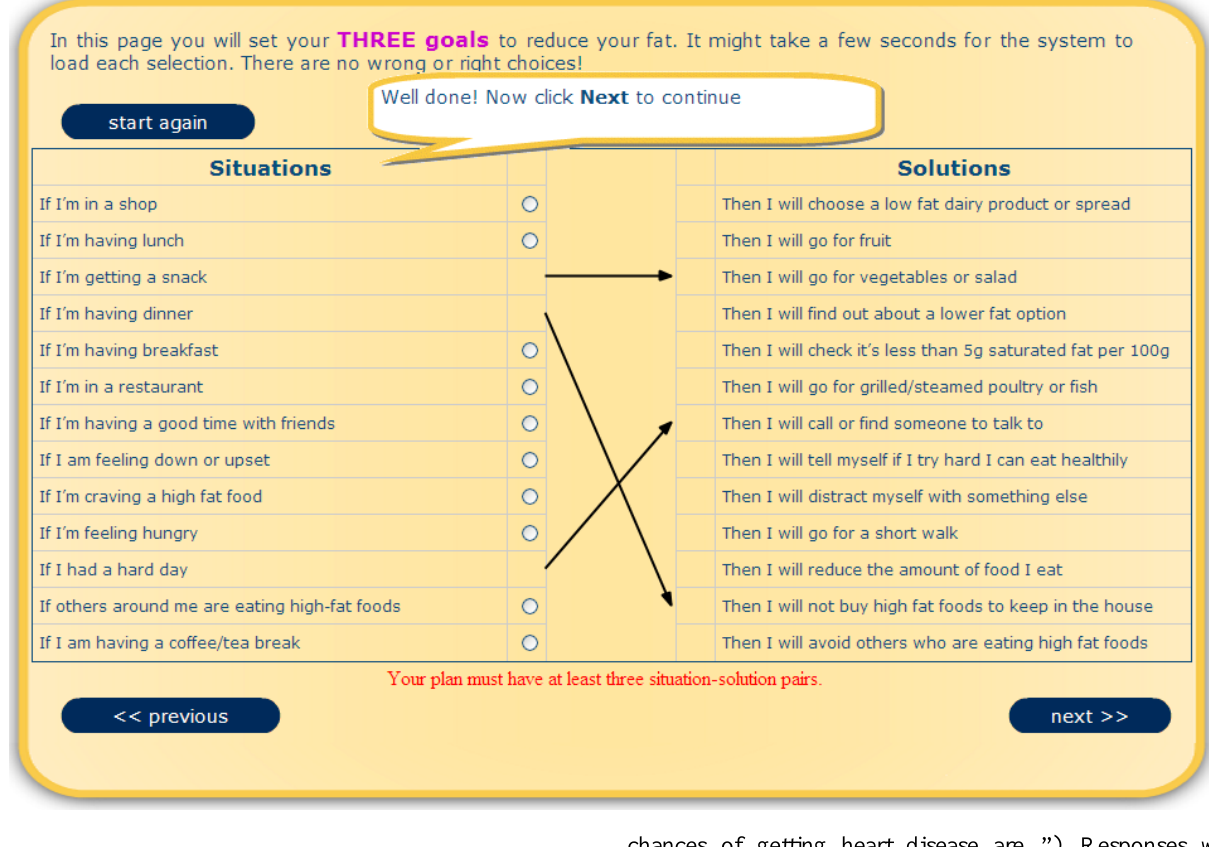
Figure 2. The planning